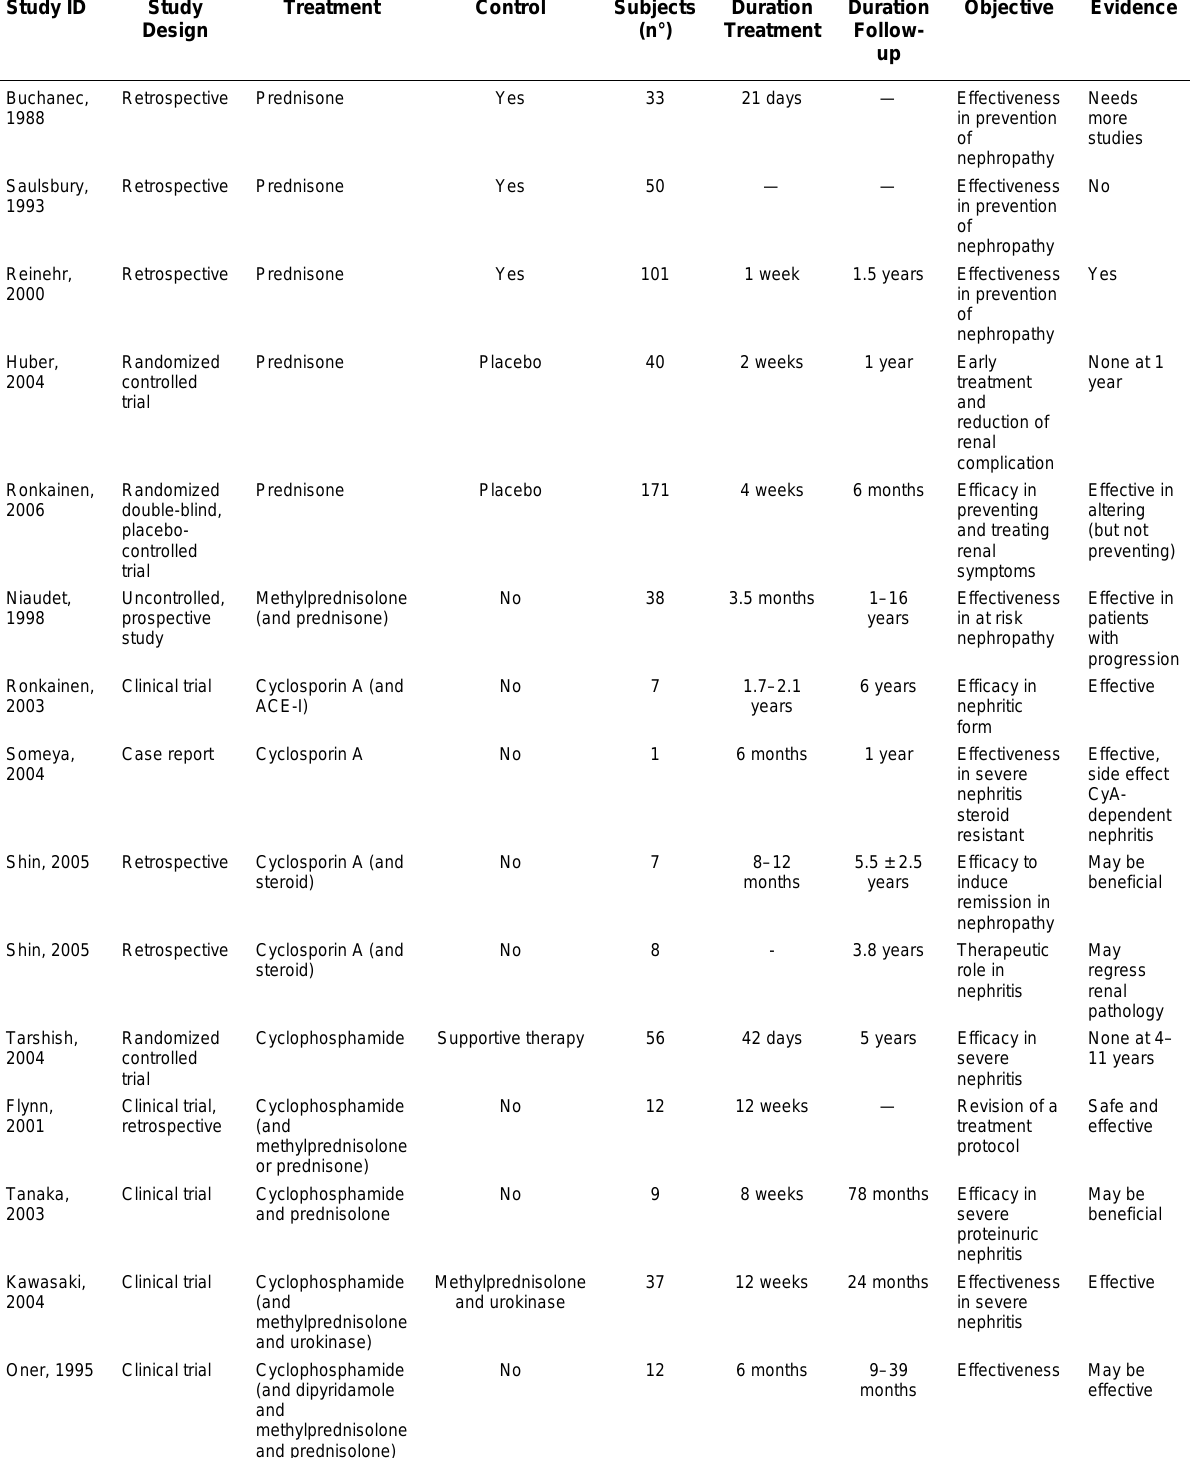
Treatment of Childhood HSP Nephritis: Results of the